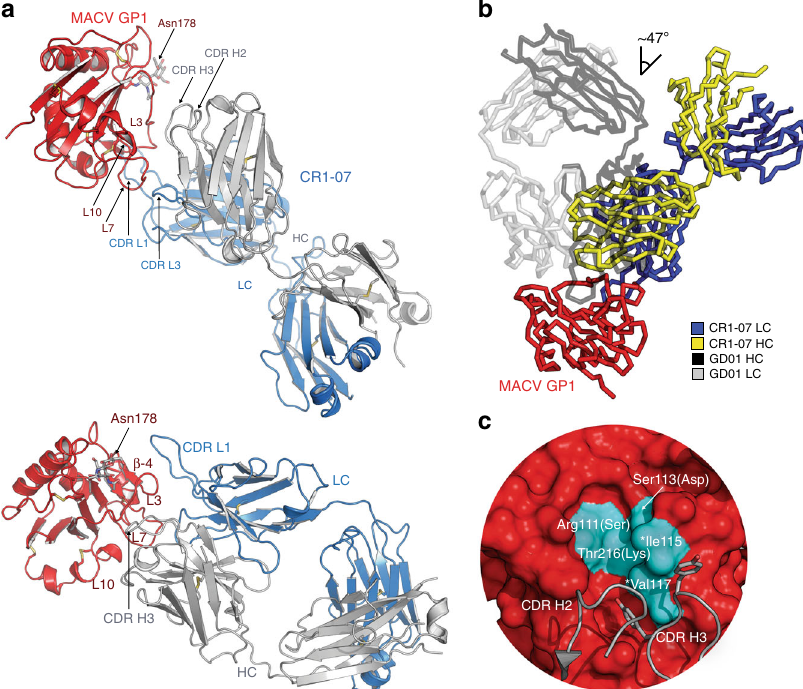
Fig. 4 Structure of a MACV GP1 CR1-07 Fab complex. a Top panel: Ribbon diagram of MACV GP1 (red) bound to the CR1-07 Fab (heavy chain in gray, light chain in blue). The antibody CDRs and GP1 segments involved in interactions are labeled. Bottom panel: Side view of the complex that allows better visualization of Fab-glycoprotein interactions. A site of N-linked glycosylation at Asn178 (for which we observed interpretable density) is shown. L: loop. LC: light chain. HC: heavy chain. Disul fi des are shown as yellow sticks. b Overlay of the JUNV GP1/GD01 Fab structure (PDB: 5EN2) 14 with the MACV GP1/CR1-07 Fab structure. The difference in the angle of Fab approach (from the perspective of the variable domain) is indicated and is similar for all copies in the ASU. c Surface representation of MACV GP1 (PDB: 3KAS) 13 with segments from the CR1-07 Fab CDRs shown in cartoon representation. Residues that line the Tyr211 TfR1 pocket in MACV GP1 are shown in cyan and labeled. Two CDR H3 tyrosines that interact with pocket residues are shown as sticks. Asterisks indicate the two pocket residues that are conserved in JUNV and MACV GP1. For the other pocket residues, which differ between MACV and JUNV GP1, the amino acid found at the corresponding position in JUNV GP1 is shown in